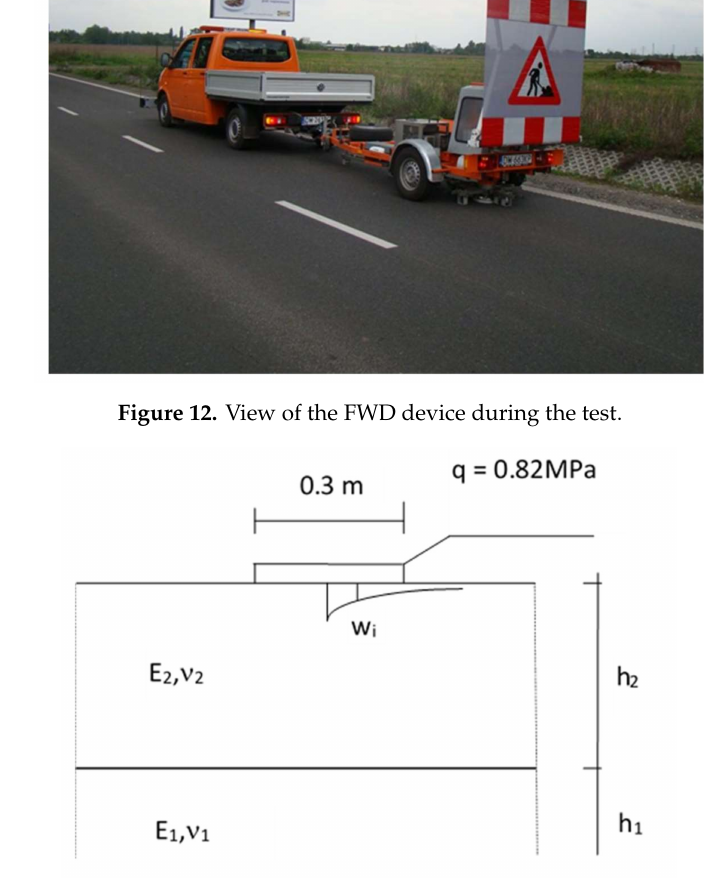
Figure 13. Calculation model of the tested pavement